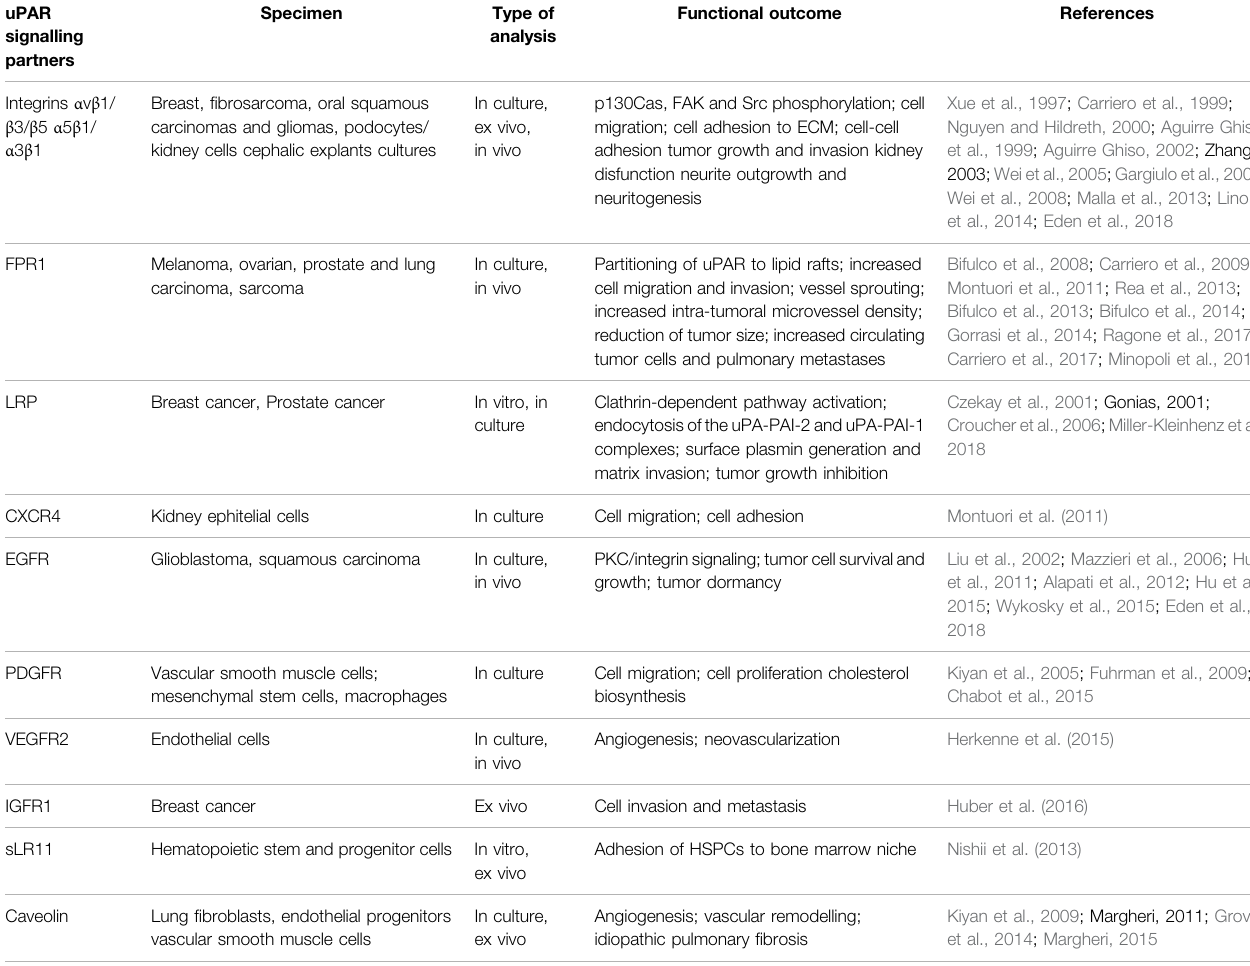
TABLE 1 | Membrane interactors of uPAR and signalling